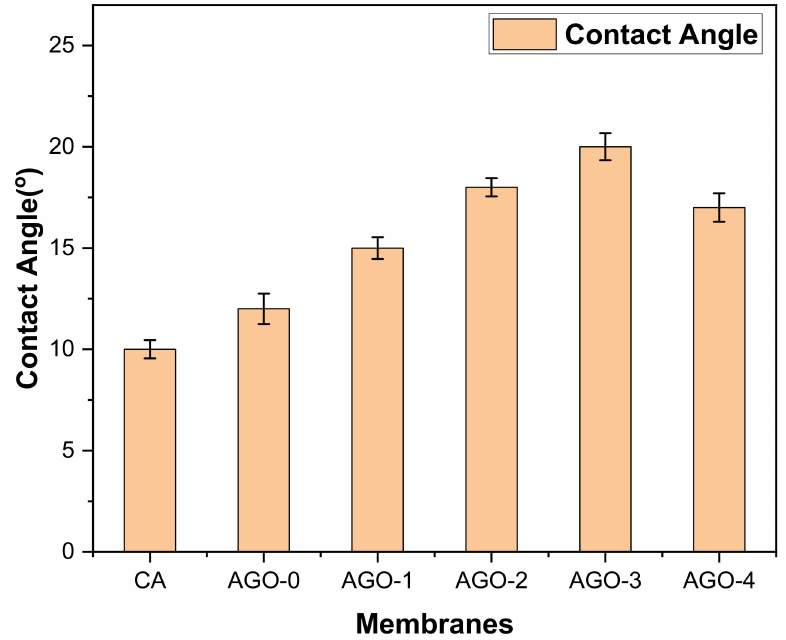
Figure 6. Contact angle of AGO